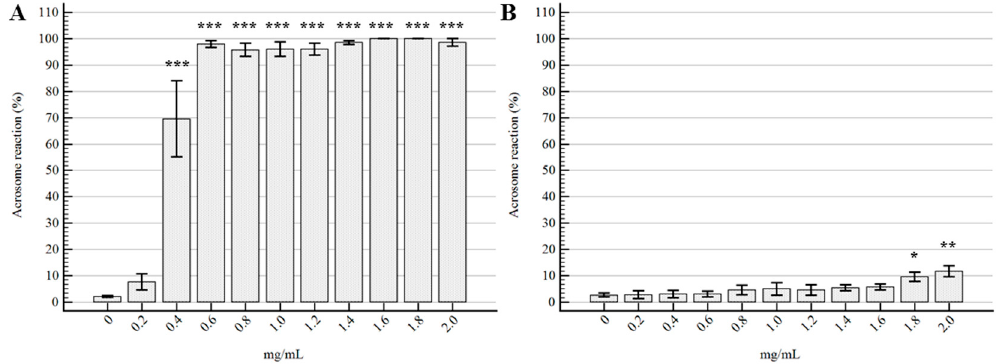
Figure 3. Effects of the EOs on acrosome status. ( A ) Thymbra capitata ; ( B ) Rosmarinus officinalis . Data are expressed as mean ± standard error of the mean ( n = 6). 0 mg/mL represents the control sample (only emulsifiers). * = p < 0.05; ** = p < 0.01; *** = p < 0.001.